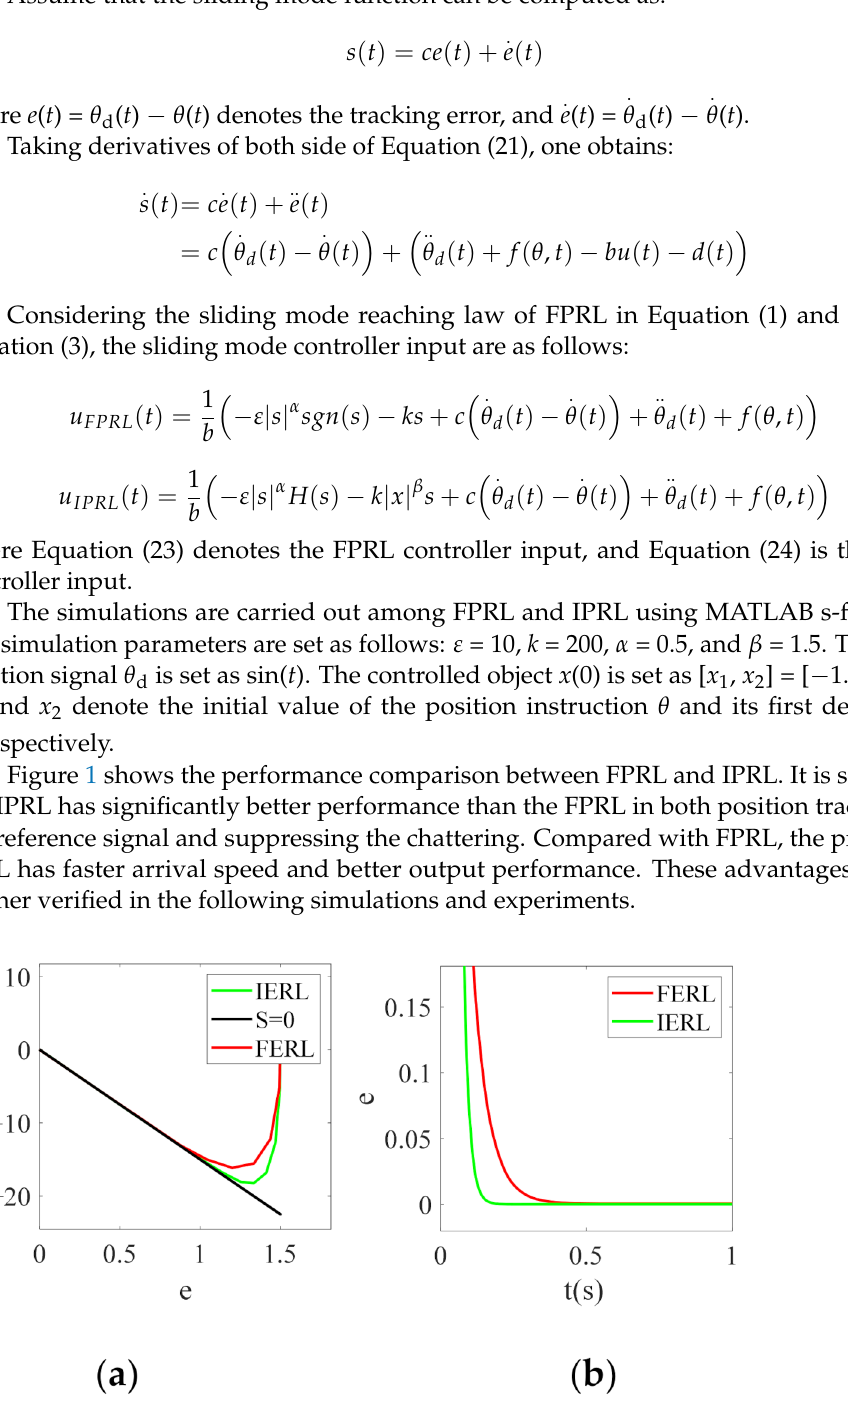
Figure 1. Performance comparison results of FPRL and IPRL: ( a ) Phase trajectory; ( b ) Error conver- gence